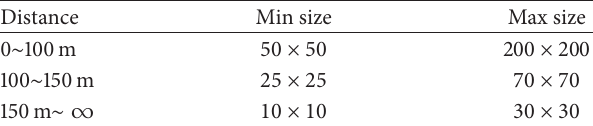
Table 1: Vehicle size range in pixel